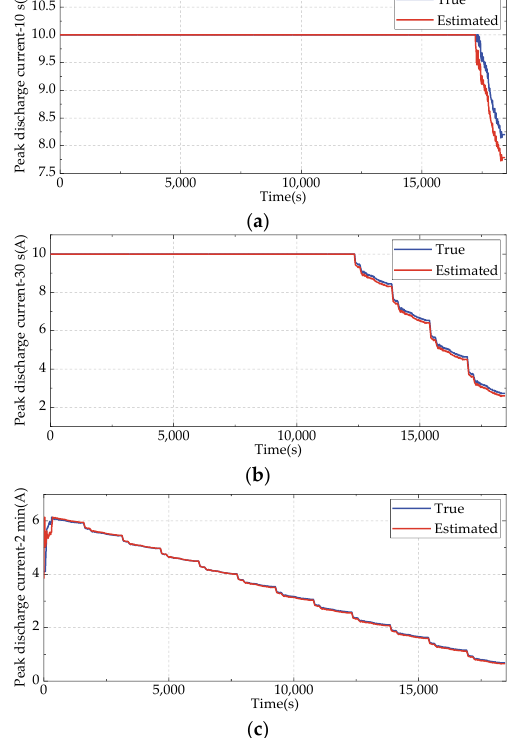
Figure 13. Results of multi-constraint peak discharge current estimation in different time scales: ( a ) 10 s; ( b ) 30 s; ( c ) 2 min.